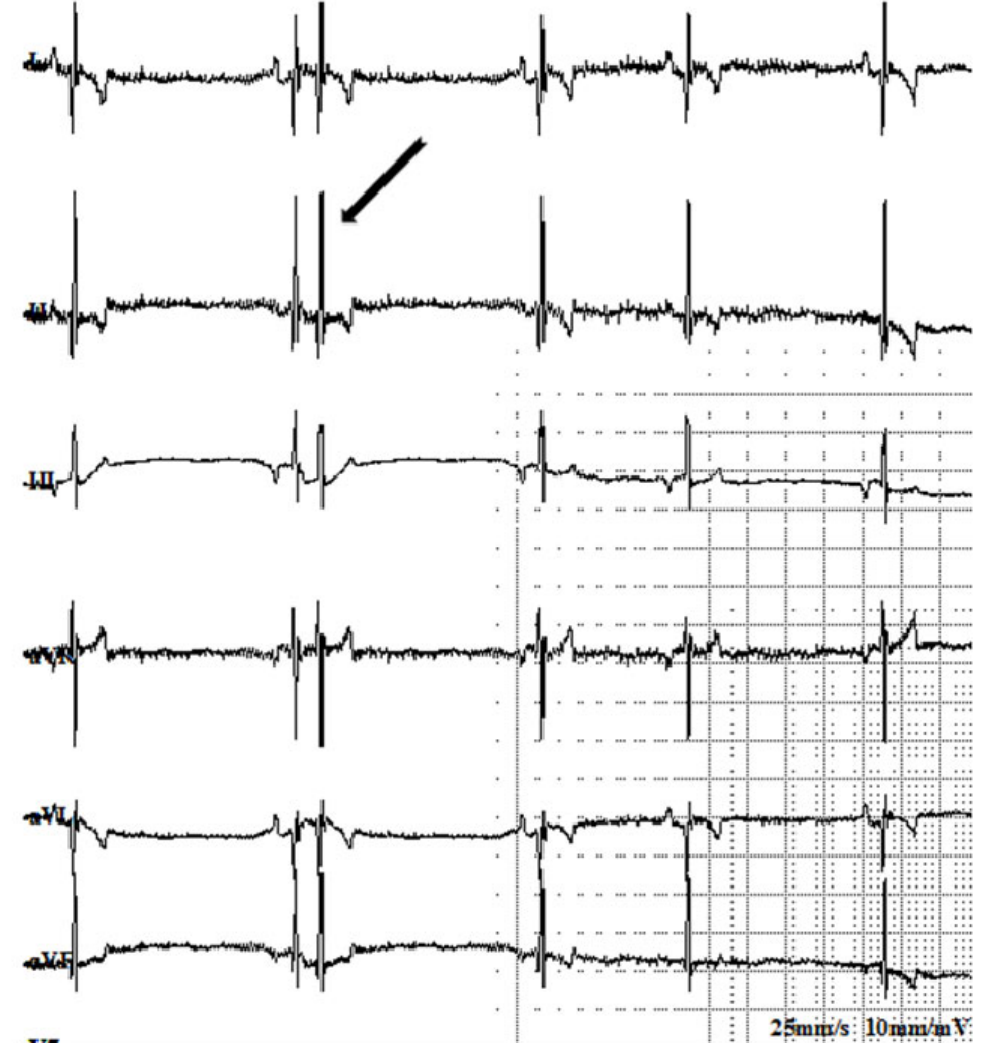
Fig. 1. Electrocardiography of the heart of a spaniel dog. Ectopic contraction. Supraventricular